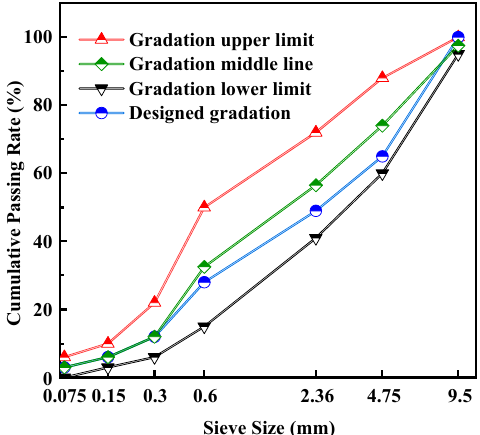
Figure 1. Aggregate and specimen slices, ( a ) coarse aggregate, ( b ) fine aggregate, ( c ) specimen section.